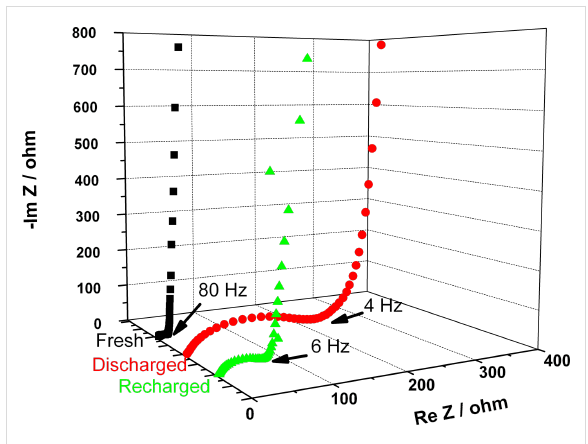
Figure 2: Electrochemical impedance spectra of pristine (black), once discharged (red) and re-charged (green) electrodes.